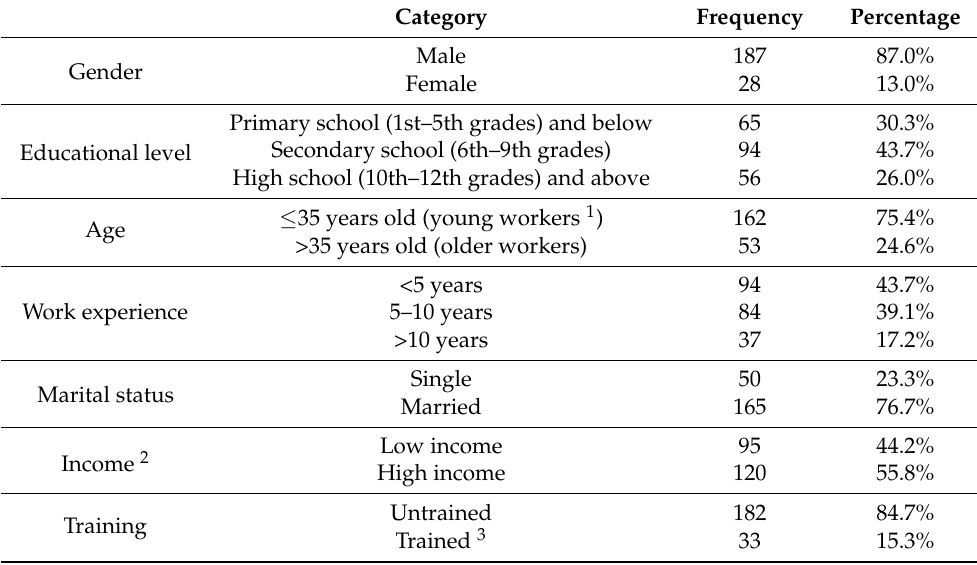
Table 1. Demographic characteristics of the